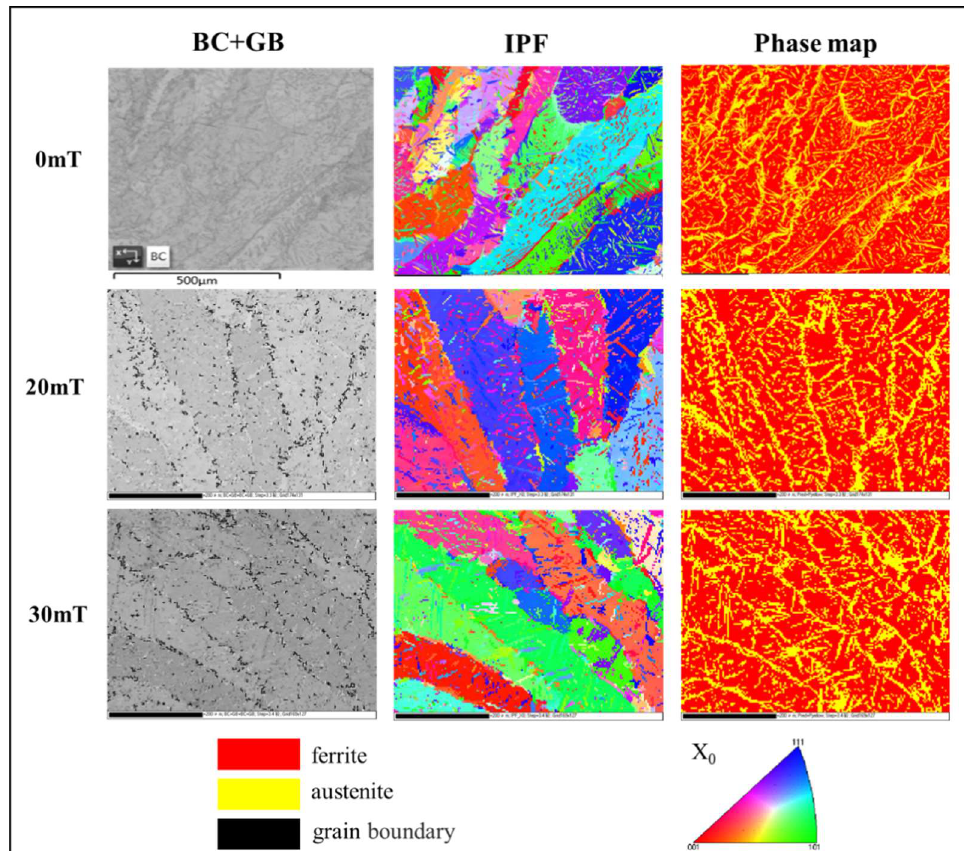
Figure 7. EBSD phase maps, IPFs in the RD direction, and band contrast of the weld under different alternating magnetic field intensities (the color codes are described in the image).